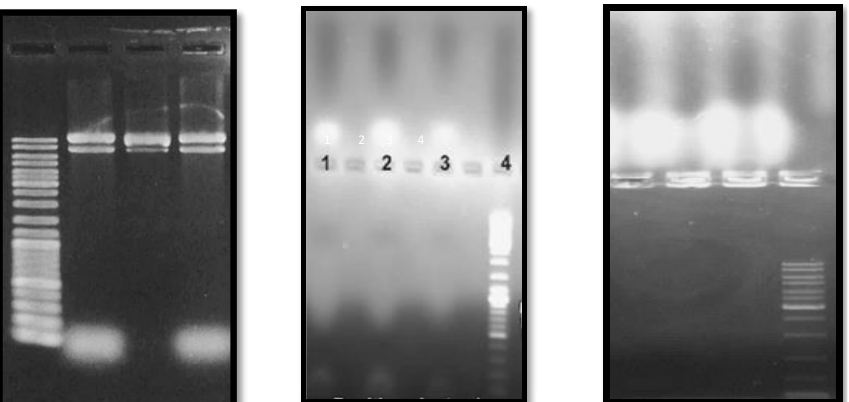
Fig. 3. Electrophoresis behaviours of DNTs on agarose gels; Left, simple DNTs; Middle, DNTs carrying MNPs on the surface and right, MNPs-encapsulated DNTs; lines 1-3, DNTs; Lines 4, DNA ladders.